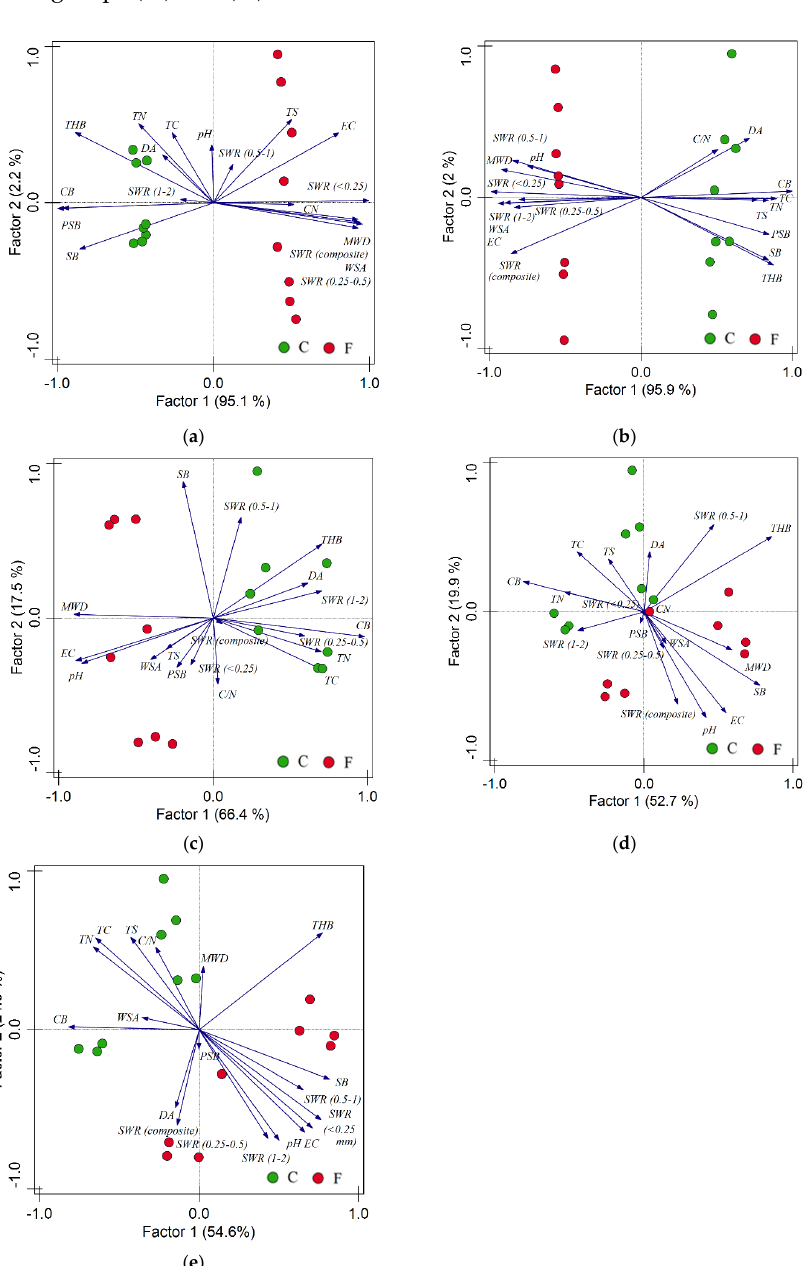
Figure 5. Principal component analysis for the relationship between factor 1 and 2. Soil water repellency (SWR; fraction values are expressed in mm), electrical conductivity (EC), total carbon (TC), total nitrogen (TN), total sulphur (TS), carbon–nitrogen ratio (C/N), mean weight diameter (MWD), water-stable aggregates (WSA), soil total heterotrophic bacteria (THB), sporogenic bacteria (SB), phosphate-solubilising bacteria (PSB), carbapenem-resistant bacteria (CRB), and dehydrogenase activity (DA) in control (C), and fire (F) treatments ( a ) immediately after the fire (IAF), ( b ) 1 month after fire (MAF), ( c ) 2MAF, ( d ) 4MAB, and ( e )